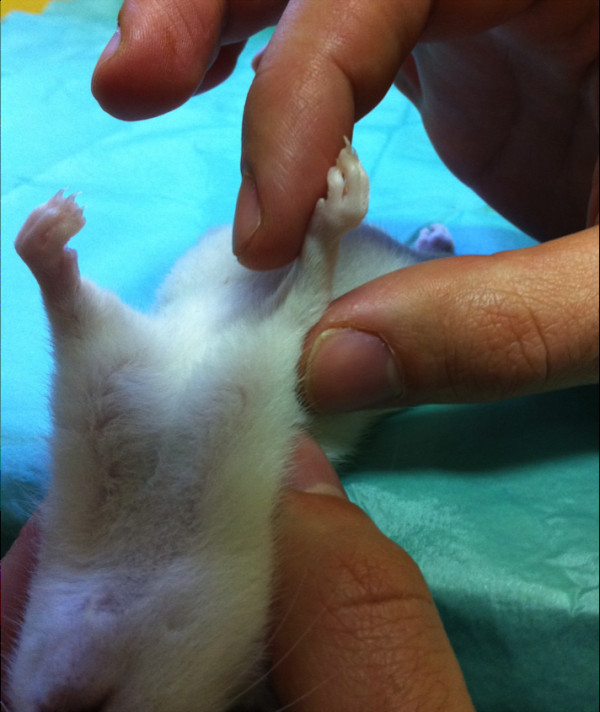
Axial vision of a rat showing a decrease of right passive shoulder external rotation 8 weeks after surgery.